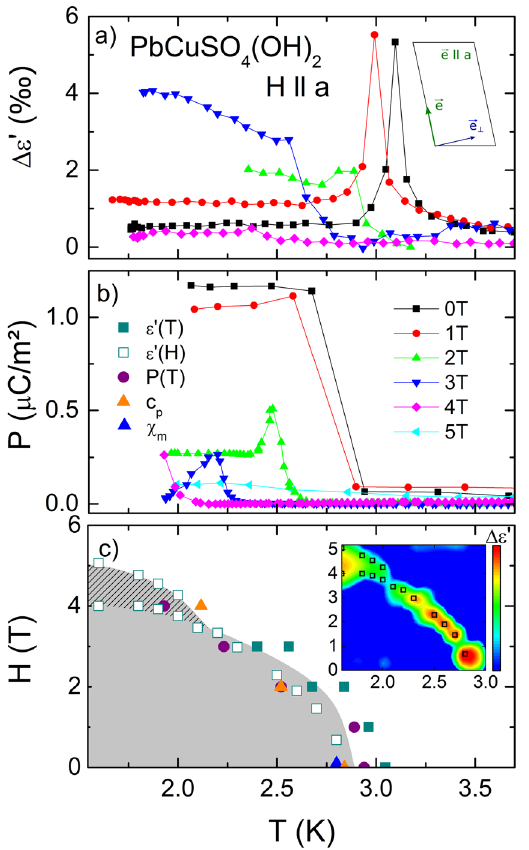
Figure 5. Dielectric properties at 300 Hz with E || a ⊥ of a PbCuSO 4 (OH) 2 single crystal with the magnetic field along the a direction. ( a ) Temperature dependent dielectric constant for various magnetic fields. The dielectric constant is normalized to a constant value and the deviation is shown in ‰. The inset illustrates the spin configuration for H > H 1 . ( b ) Temperature dependent electrical polarization performed for different magnetic fields with a poling field E pol = 2 kV/cm. ( c ) ( T , H ) phase diagram, which results from the present work. The inset shows a heat map of the temperature and magnetic field dependent deviations in dielectric constant, the peak positions are denote by the open